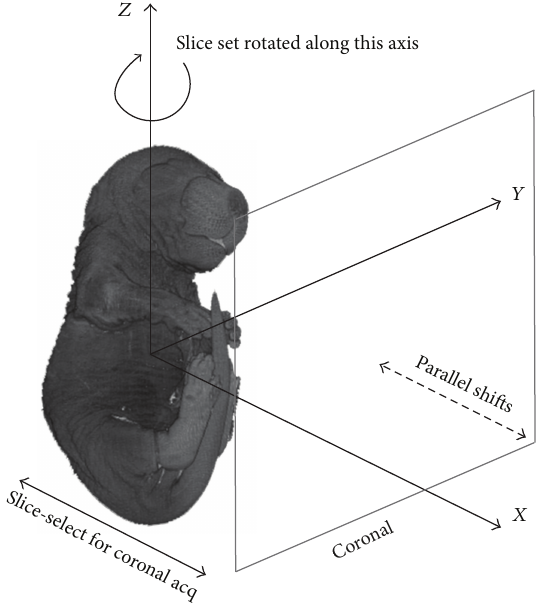
Figure 3: Schematic illustrating the orientation of the ex vivo embryo with respect to the slice-select direction of the acquisition geometries.